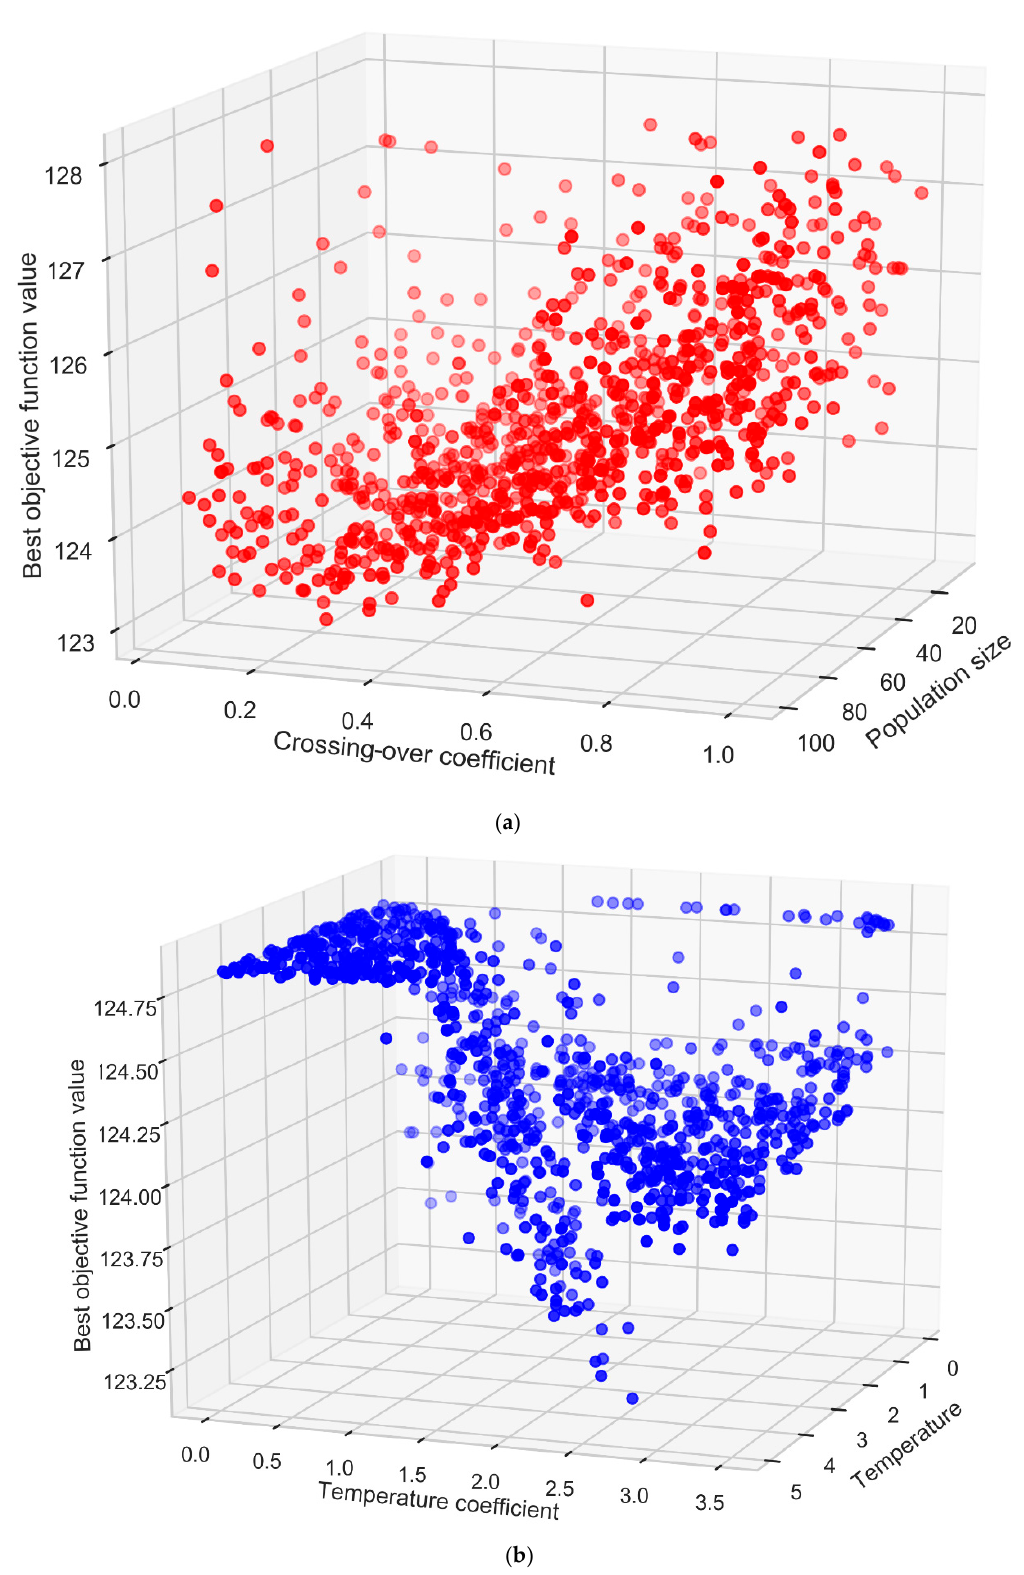
Figure 4. State space for the resultant generator maintenance scheduling objective function for: ( a ) the differential evolution method; ( b ) the very fast simulated annealing method.